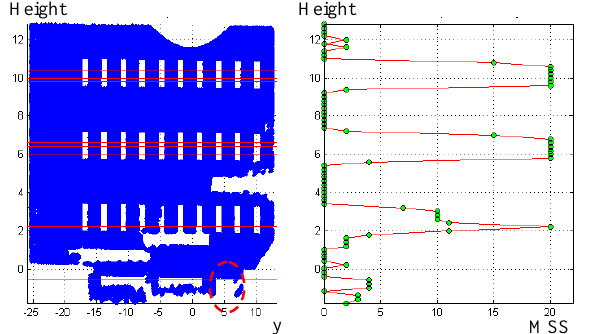
Figure 6. Result of maximum sequential similarity